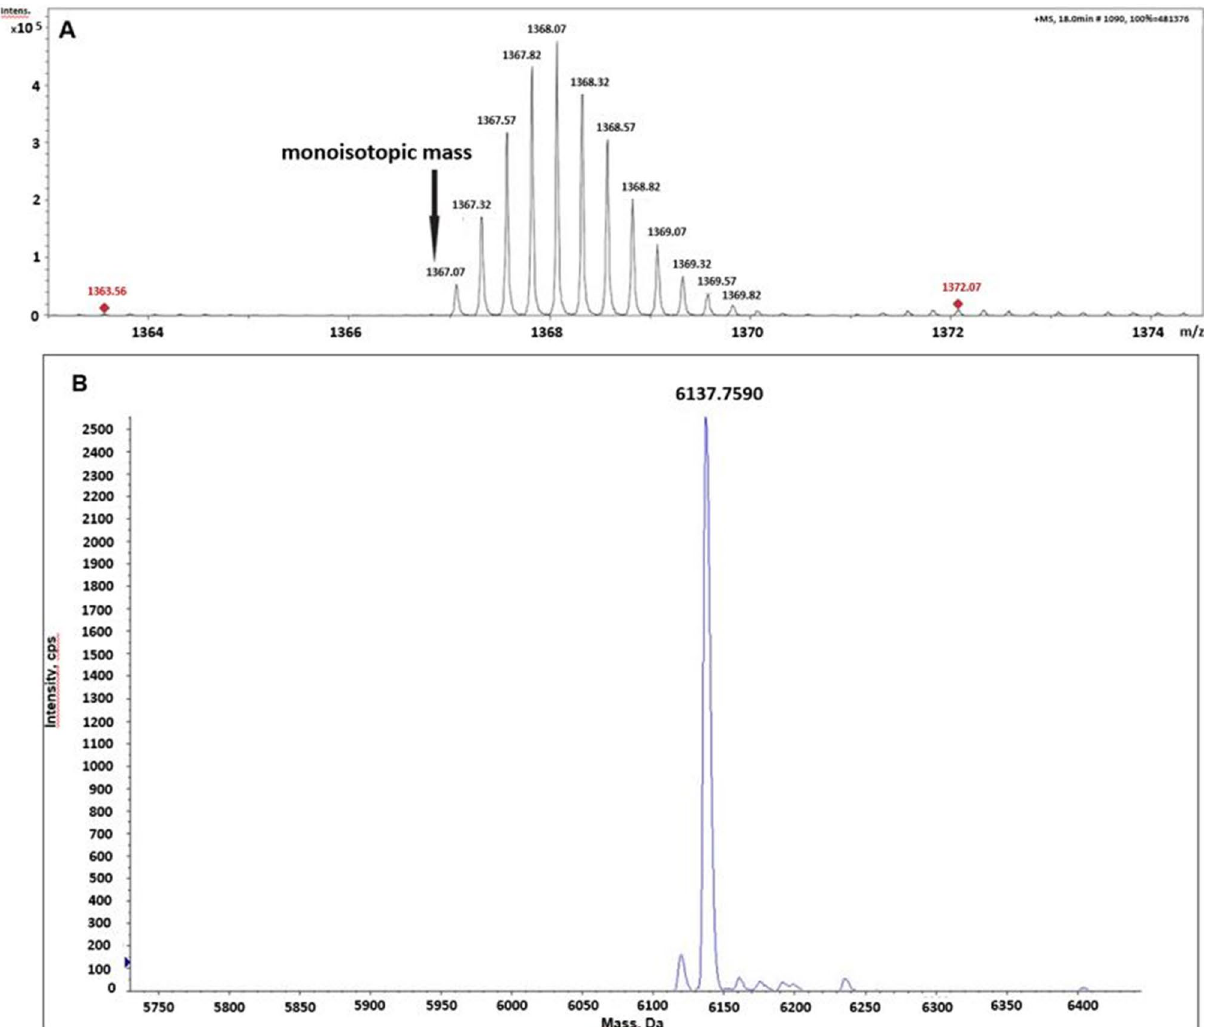
Figure 8. PDFL1.1 and PDFL2.1 contain the disulfide bridges. ( A ) ESI–MS spectrum of PDFL1.1 shows the mass of 5468.28 Da which corresponds to the calculated mass of 5468.22 Da (-6 H) confirming that the peptide has 3 disulfide bridges. ( B ) TOF–MS spectrum of PDFL2.1 shows the mass of the peptide as 6137.75 Da confirming the calculated mass of 6138.22 Da (-6